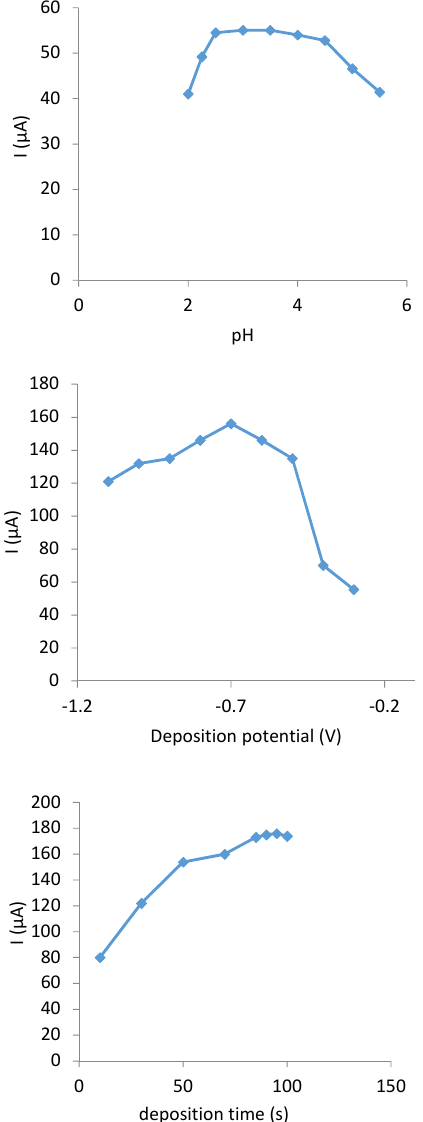
Fig. 3. Effect of pH (a), accumulation potential (b) and accumulation time (c) on the analytical signal of 0.9 µg mL -1